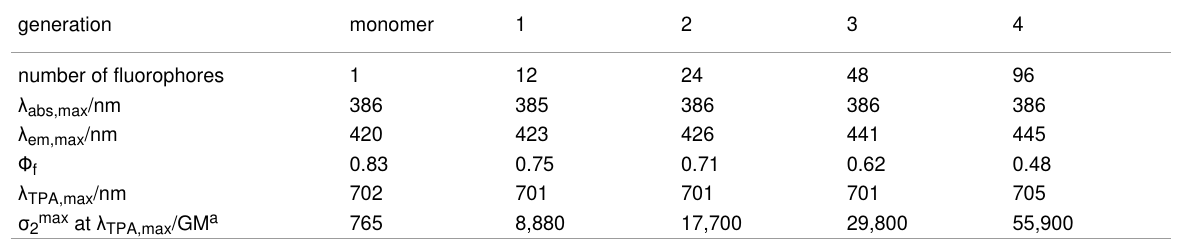
rescent markers competitive and complementary to quantum dots. This work allowed access to a variety of dendrimers with different emissive colors, by tuning the structure of the quadrupolar fluorophores grafted [44], and not depending on the size, contrarily to quantum